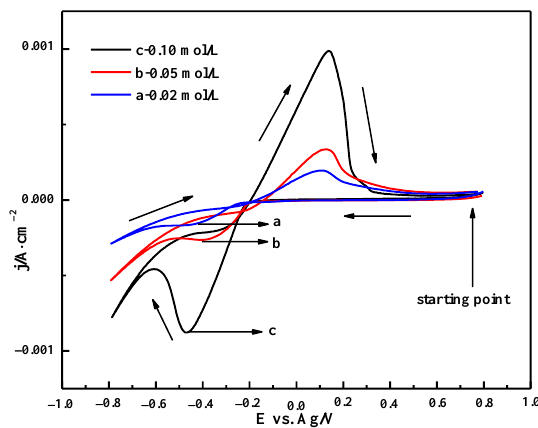
Figure 12. Cyclic voltammetry curves of ChCl-MA-BiCl 3 at different concentrations (v = 50 mV · s − 1 , T = 343 K).